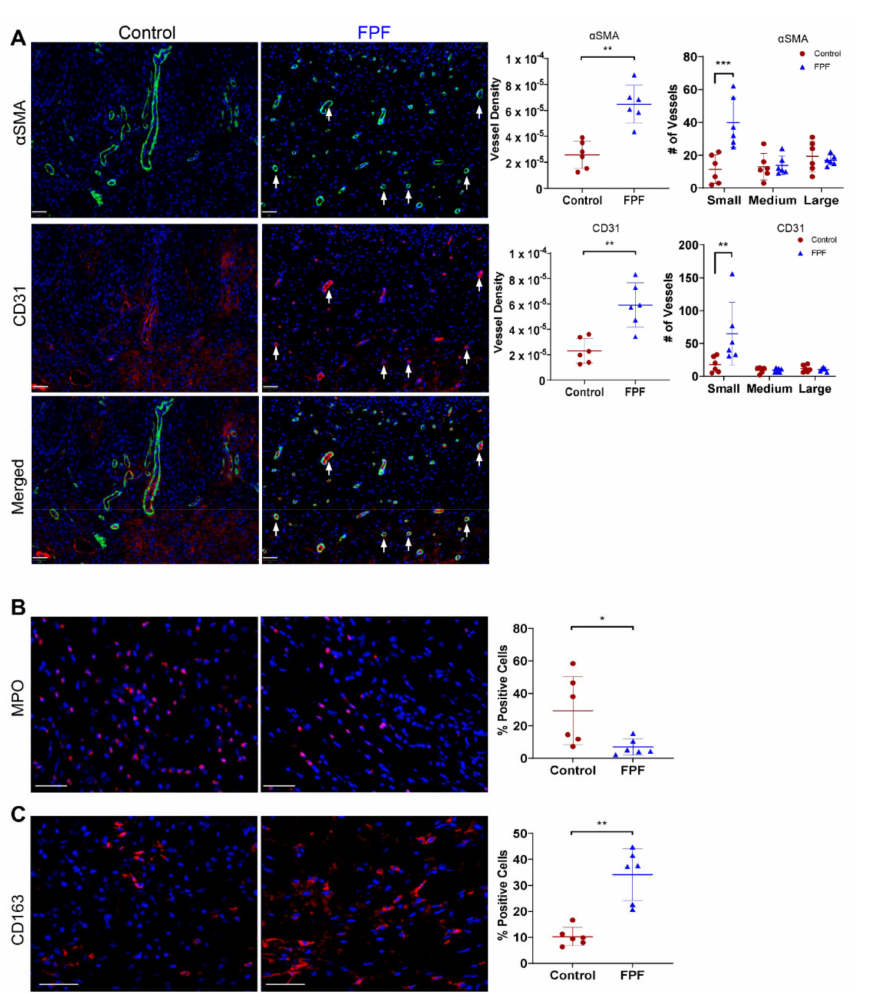
Figure 5. Angiogenic and anti-inflammatory response in FPF-treated wounds. ( A ) Neovasculariza- tion in control (left panel) and FPF treated (right panel) tissue samples collected after wound closure was determined by α SMA (top panel, stained green) and CD31 (middle panel, stained red). Merged images (bottom panel) show the colocalization of α SMA and CD31. Nuclei were counterstained with DAPI (blue). White arrows indicate α SMA- and CD31-positive blood vessels. Graphs represent the vessel density and size distribution of α SMA and CD31positive blood vessels. Scale bar = 50 µ m. N = 6 for saline; N = 9 for FPF group. Inflammatory cell staining was determined by ( B ) MPO (red) staining for neutrophils. Scale bar = 50 µ m and ( C ) CD163 (red) staining for M2 macrophages. Scale bar = 50 µ m. Nuclei were counterstained with DAPI (blue). N = 6/group. * p < 0.05, ** p < 0.01, *** p <